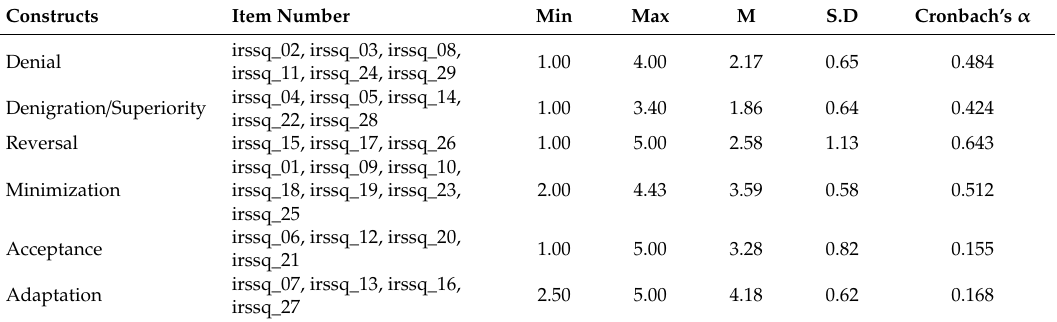
Table 4. Descriptive statistics of IRSSQ